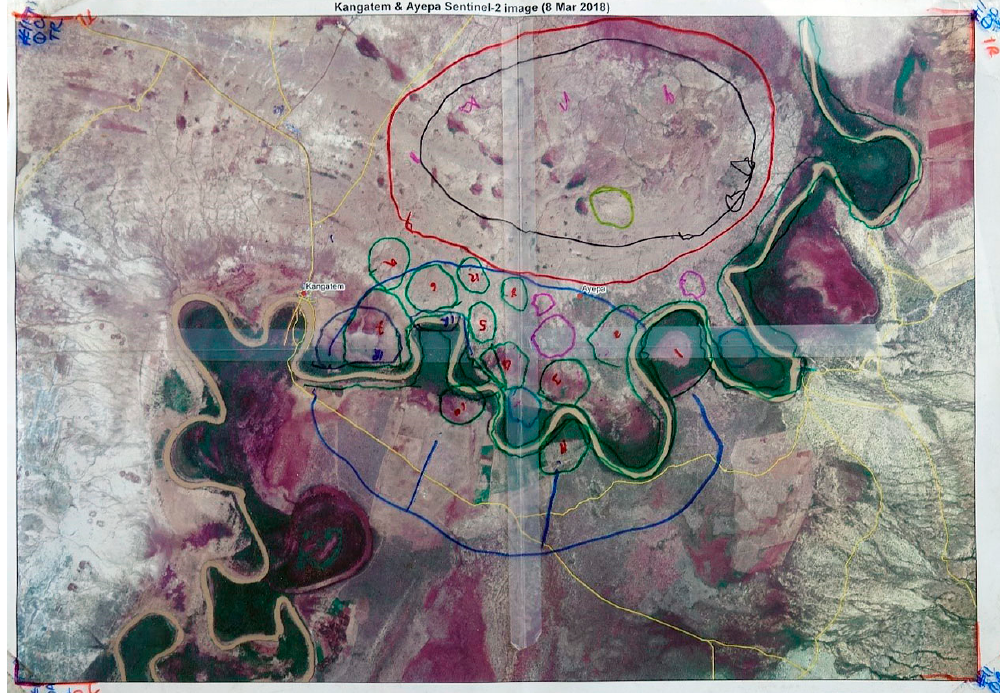
Figure 3. Participatory map from the Ayepa men’s focus group, shared with permission from the participants. The map shows pond agriculture (red), flood-retreat agriculture (green), wet season grazing (black), and dry season grazing (blue), plus schools (pink) and ceremonial sites